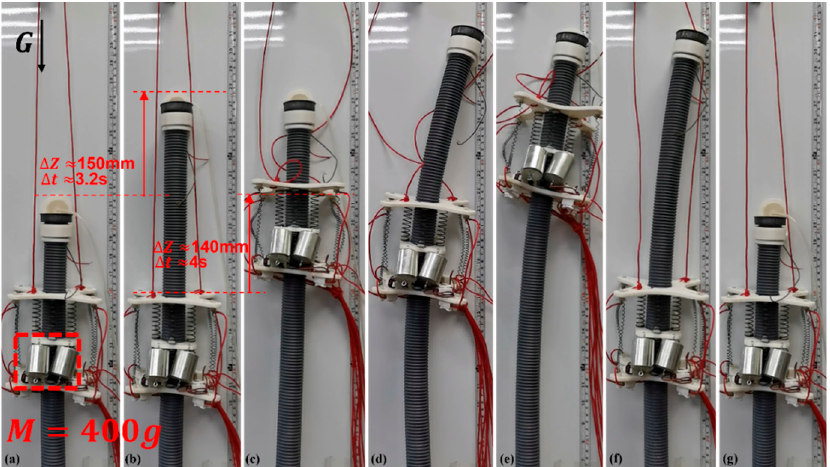
Figure 19. Maximum payload test of single module prototype. ( a – g ) represents the motion of the robot.